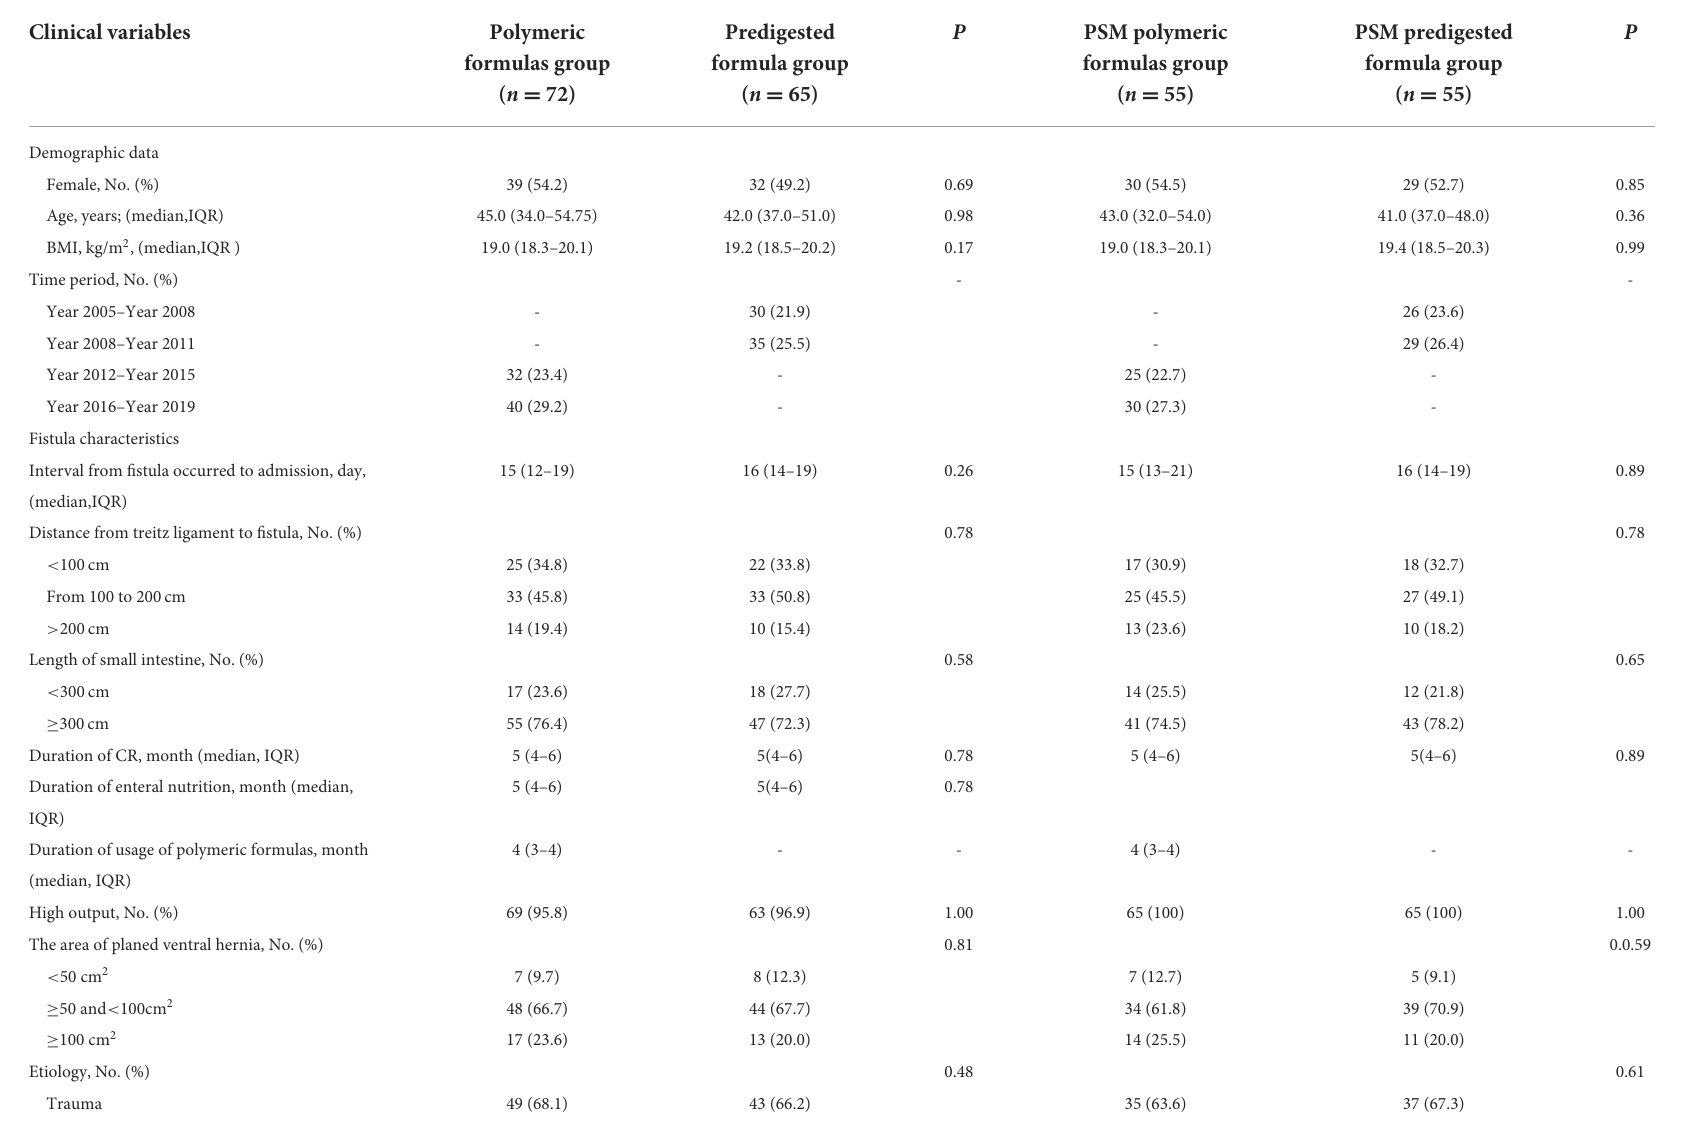
TABLE 1 Patients